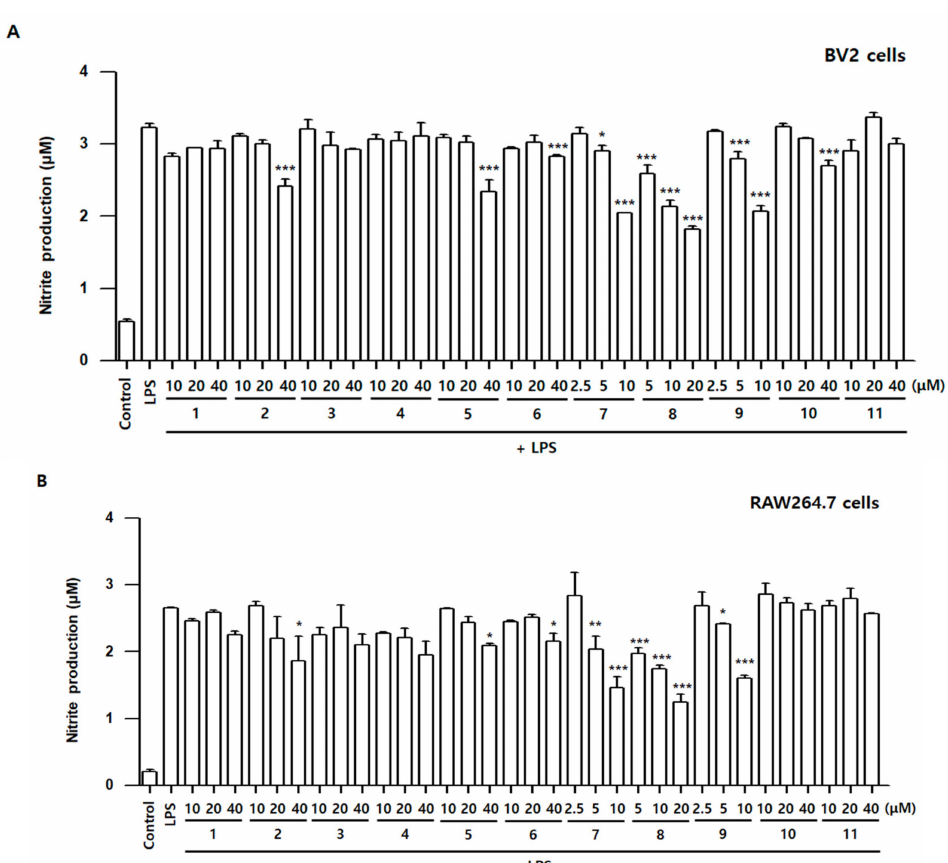
Figure 4. Effects of Compounds 1 – 11 on nitrite contents in LPS-stimulated BV2 ( A ) and RAW264.7 ( B ) cells. Cells were pretreated for 3 h with indicated concentrations of compounds 1 – 11 and stimulated for 24 h with LPS (1 µ g/mL). Nitrite concentration was performed as described in Materials and Methods. Bars represent means ± standard deviation of three